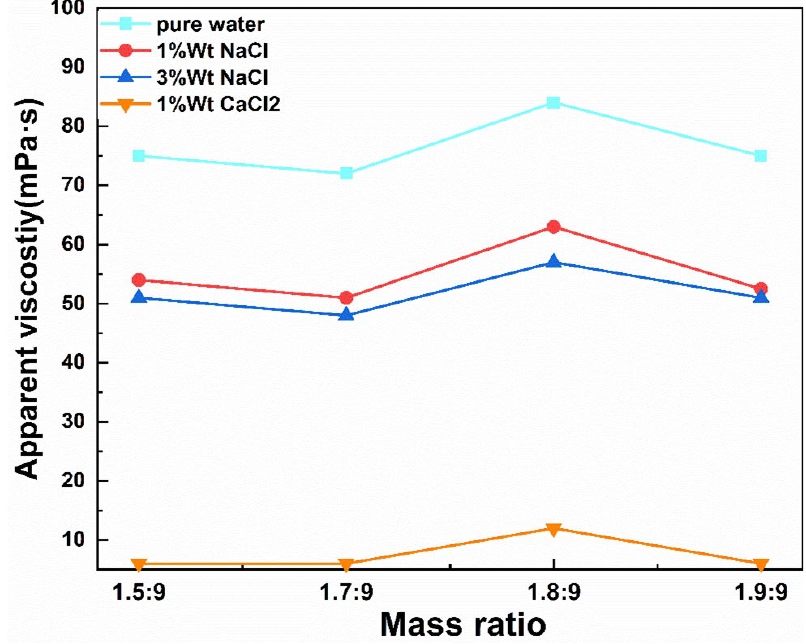
Figure 1. Influence of mass ratio on generator viscosity.